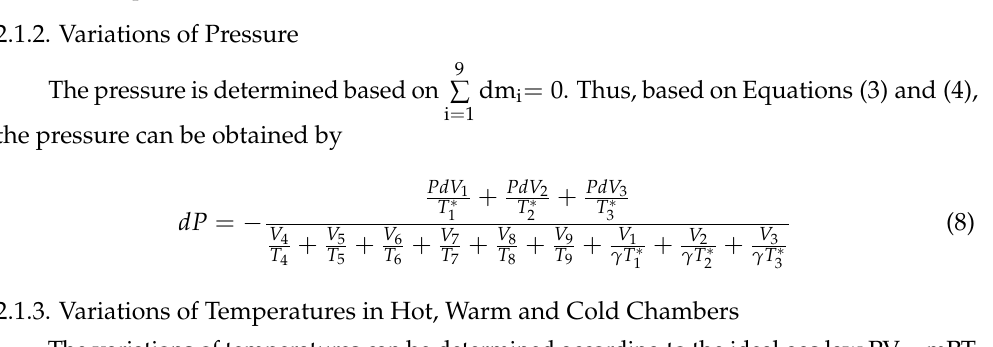
Figure 3. Temperatures in Vuilleumier machines.